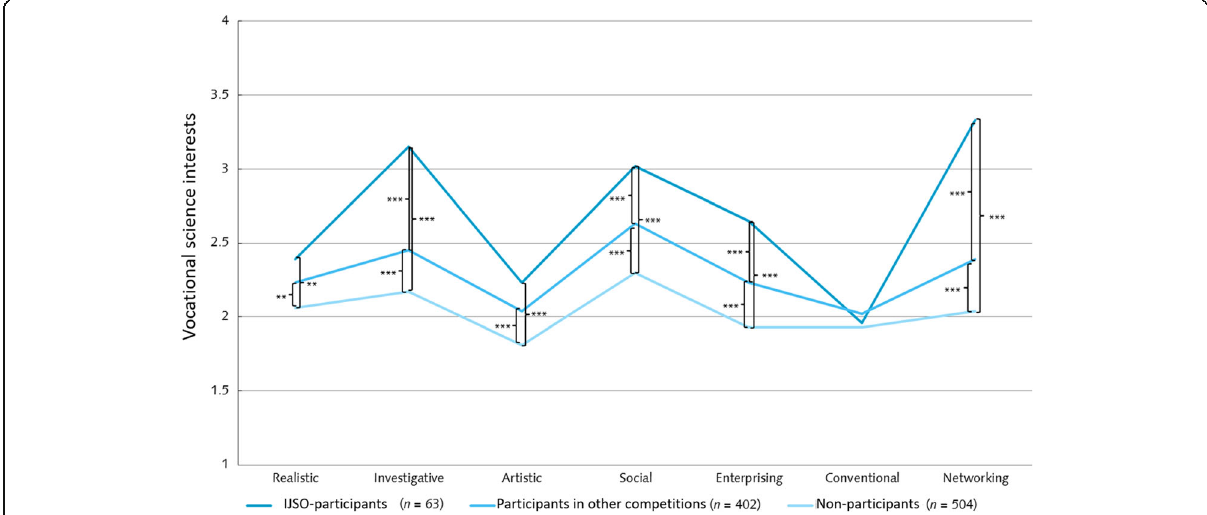
Fig. 2. Vocational science interest profiles. Interest profiles of IJSO participants, non-participants, and participants in other science or mathematics competitions in comparison. Statistically significant differences are marked (*** p < 0.001; ** p <